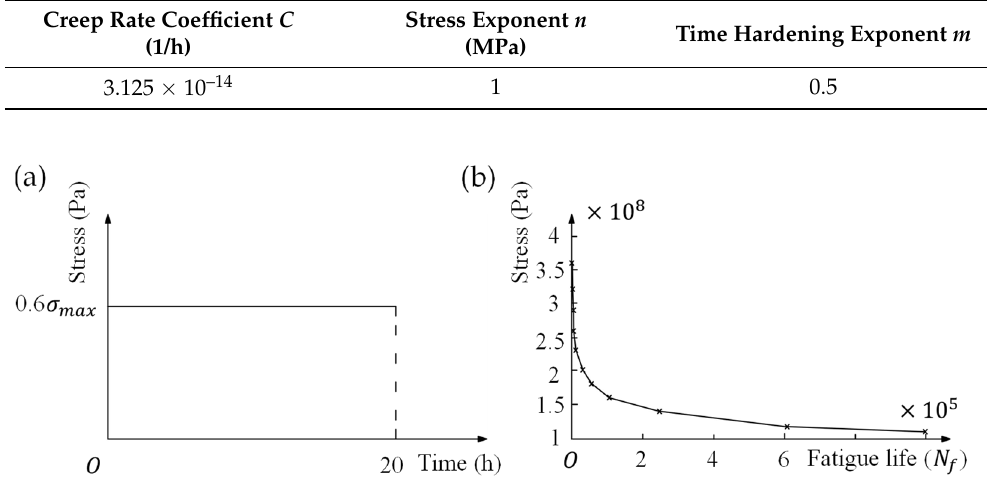
Figure 8. Creep strain of sensitive grids with varied surface roughness when the applied load equals the ultimate stress of 𝑃 (cid:3404) 60% 𝜎 (cid:3040)(cid:3028)(cid:3051) . Creep strain for a longitudinal ( a ) and transverse ( b ) surface texture mode in sensitive grids; ( c ) creep strain for the side-wall profile of sensitive grids.